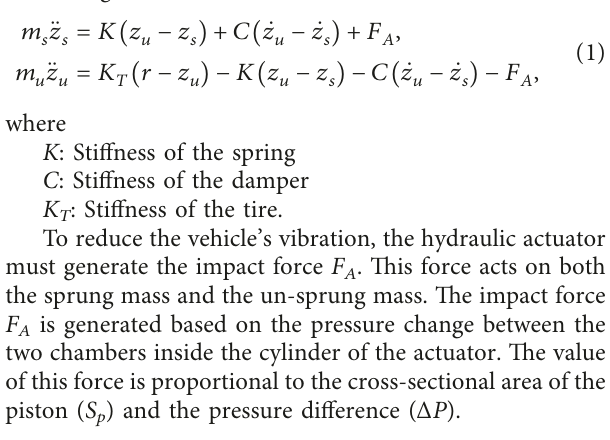
Figure 1: Model of the vehicle